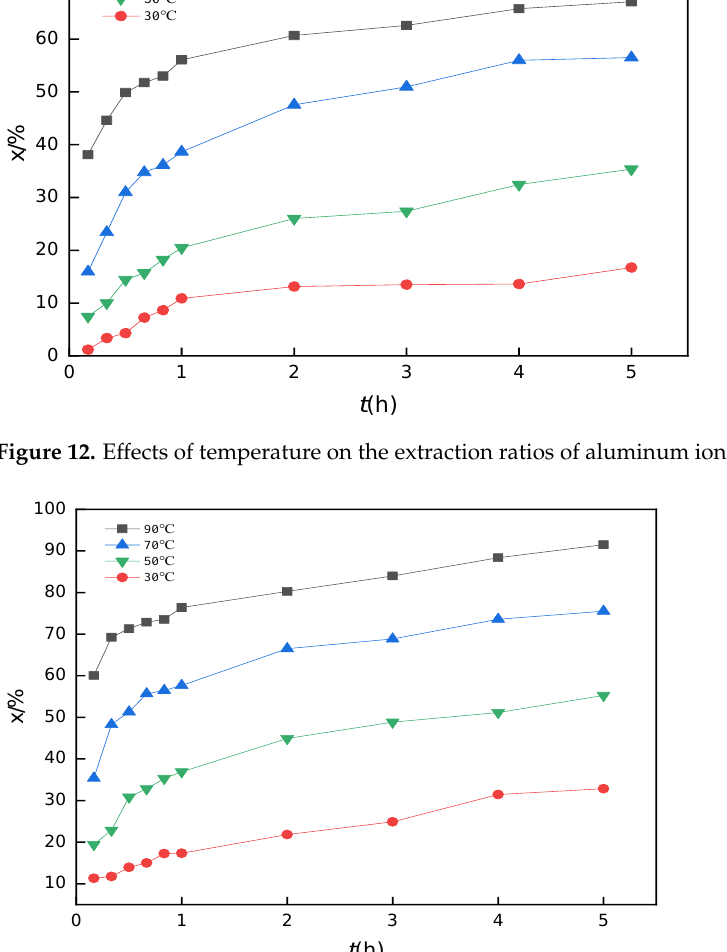
t ( h ) Figure 14. Relationships between 1 − 2/3x − (1 − x) 2/3 and time of aluminum ions.